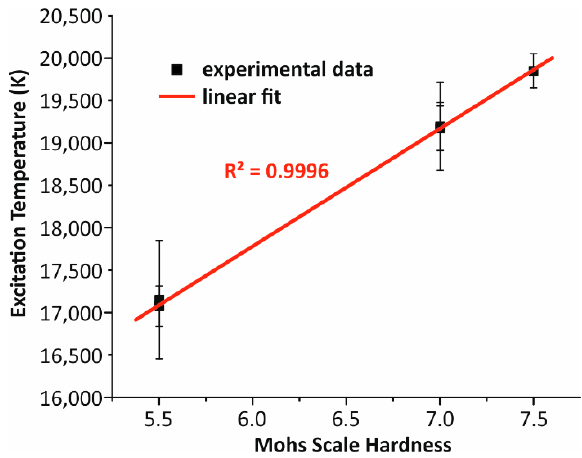
Figure 9. Excitation temperature vs. Mohs’s hardness.